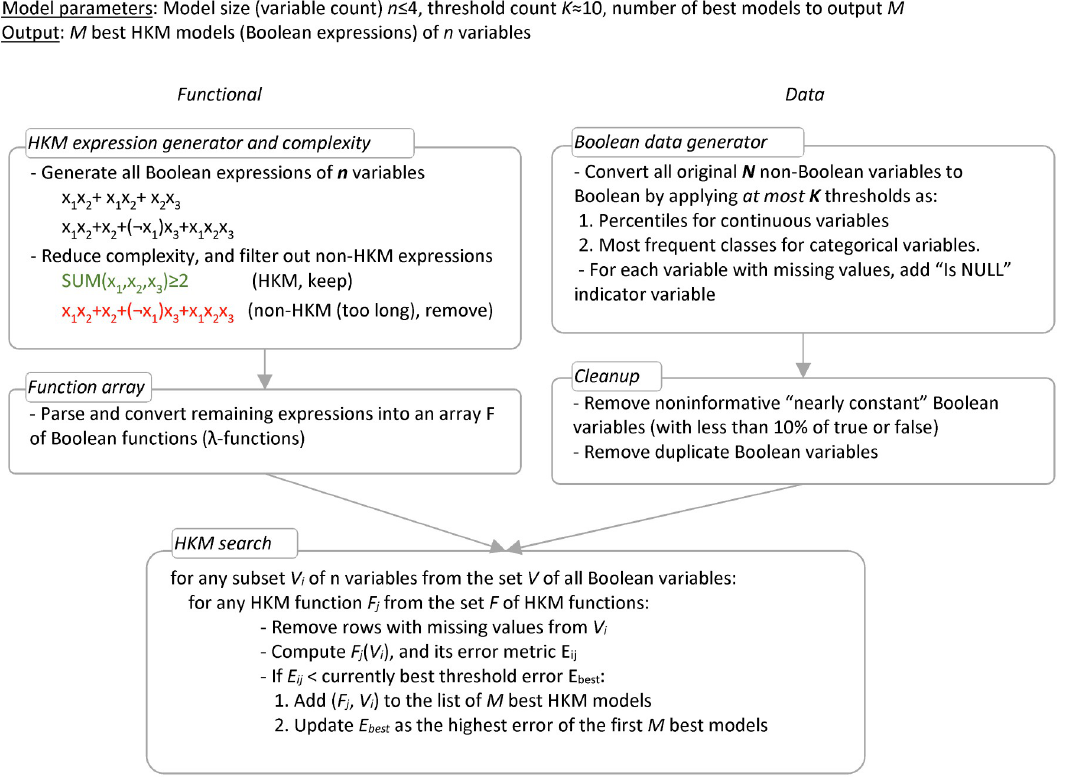
Fig 2. HKM algorithm outline. Note that the HKM search loop can be easily computed in parallel.